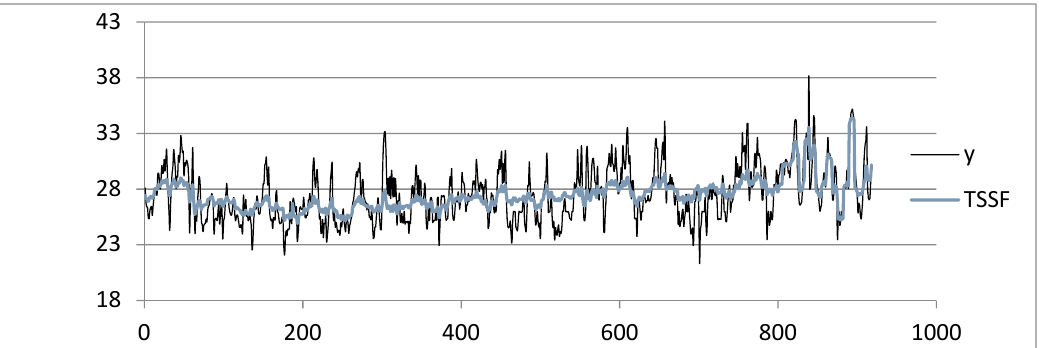
Figure 5. Plot of HI index time series from the Napoli Capodichino station dataset obtained by using the TSSF algorithm.